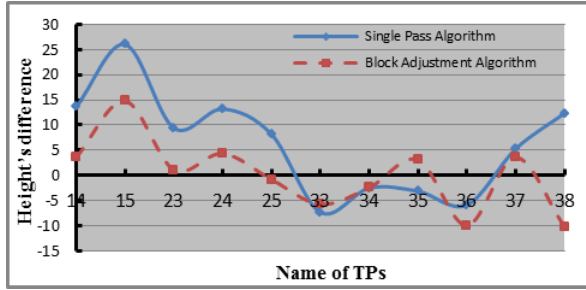
Fig.10 Distribution of Heights’ Differences on Tie